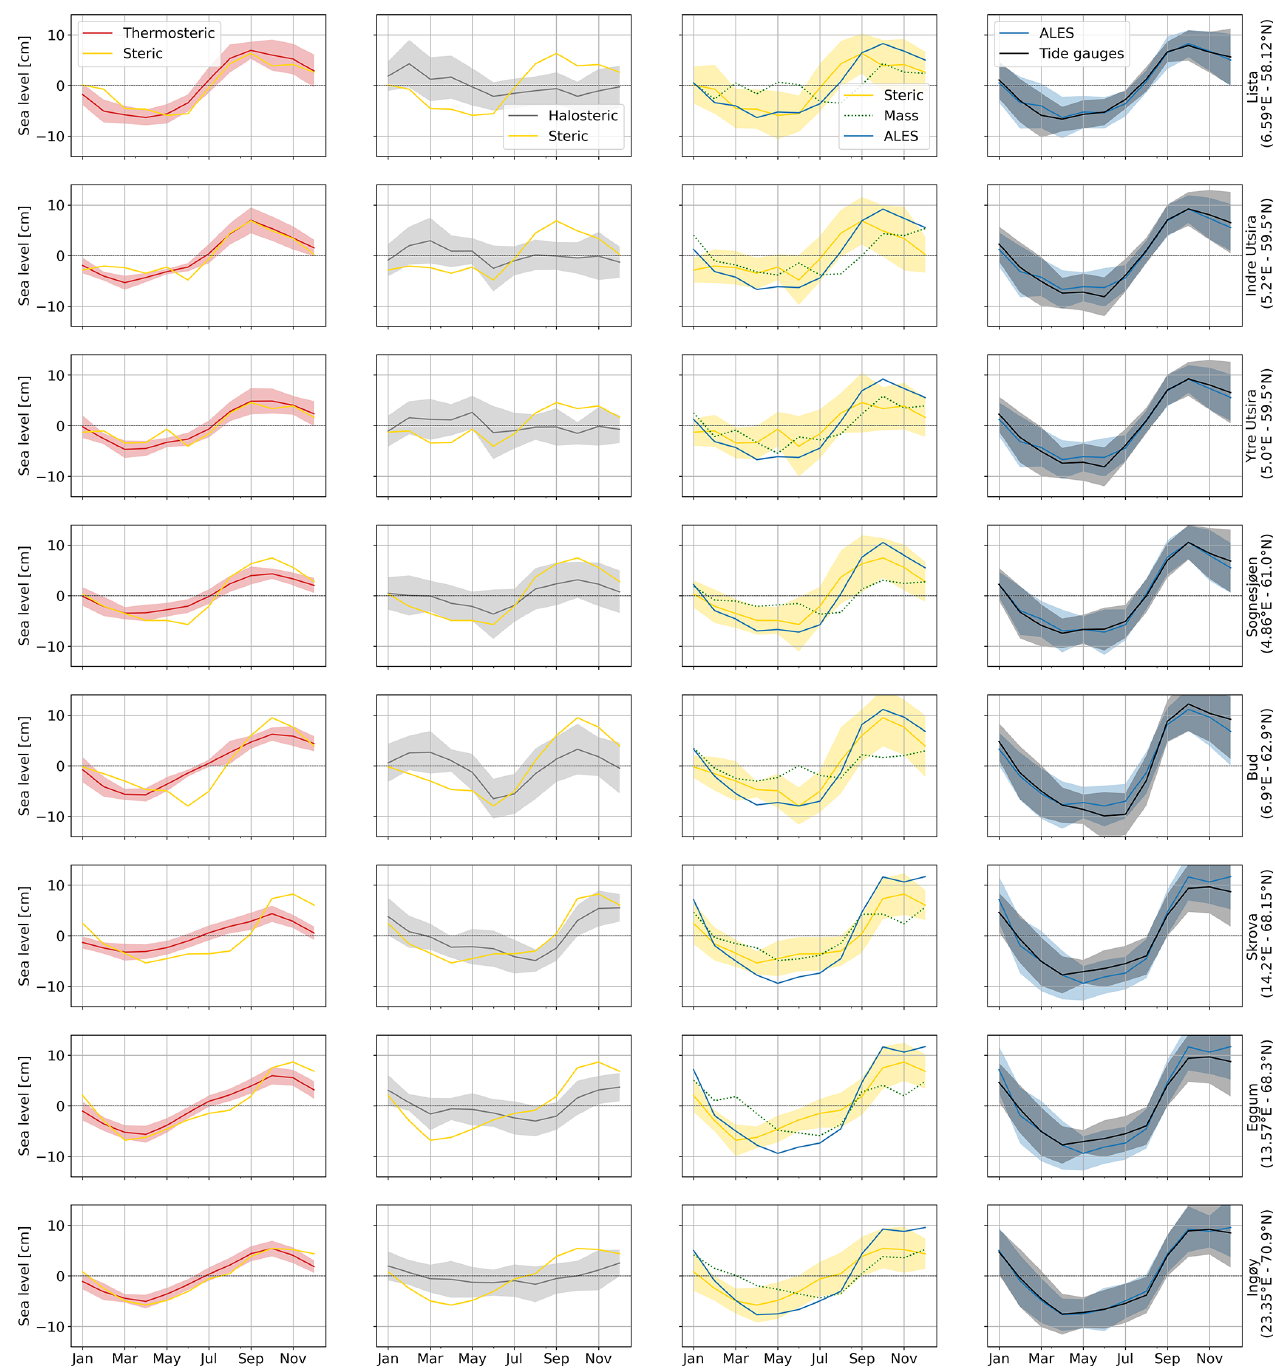
Figure 13. Monthly climatology of the sea-level signals at the hydrographic station positions. The panels show the steric (yellow lines), thermosteric (red lines), halosteric (gray lines), and mass (green lines) components of the sea level. The monthly climatology obtained from altimetry (blue lines) and tide-gauge (black lines) measurements is also shown. The shading enveloping the monthly climatologies shows the region departing from each line by 1 climatological standard